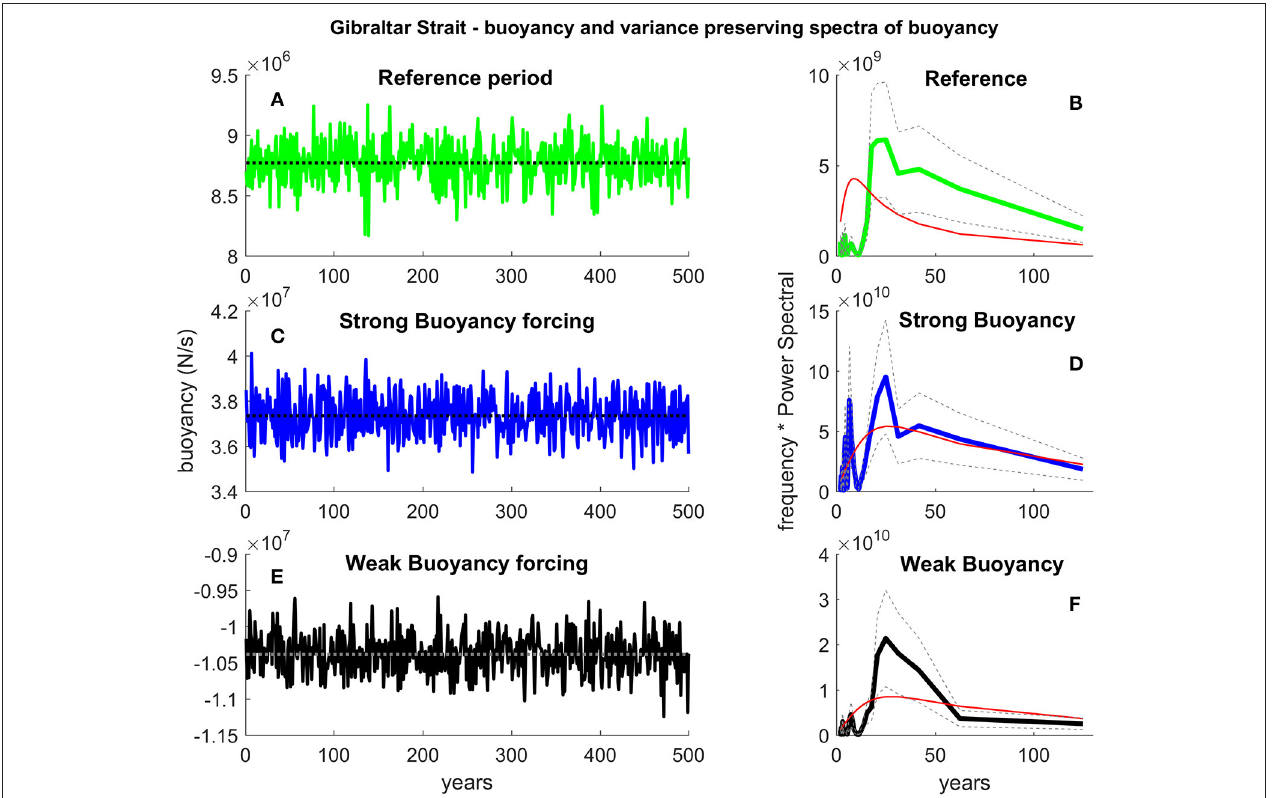
FIGURE 6 | Transect-integrated buoyancy fluxes (A,C,E) and variance-preserving spectra (B,D,F) through the Gibraltar Strait of the last 500 years of simulations with the diagnosed fluxes for the reference (A,B) , SBF (C,D) and WBF (E,F) experiments. The dashed gray lines surrounding the mean spectral estimate correspond to the 90% confidence intervals. For comparison, the corresponding normalized red noise of the same variance is overlaid (red lines). Positive values correspond to eastward buoyancy